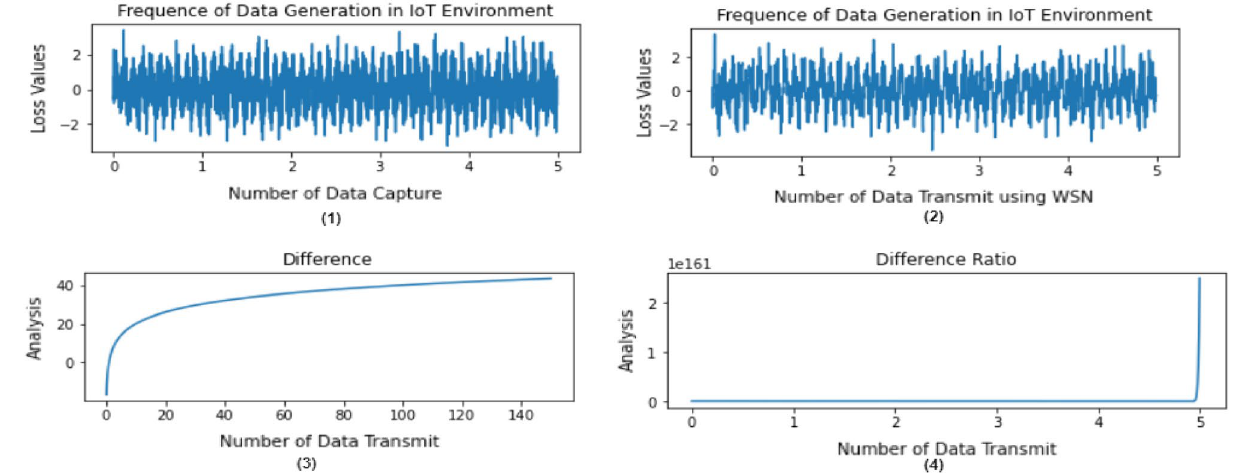
Figure 5. Frequency of data generation in IoT environment, ( 1 ) shows the number of data capturing, ( 2 ) shows the number of data transmitting, ( 3 ) shows the difference between the number of data transmission and analysis ( 1 ), and ( 4 ) shows the difference between the number of data transmission and analysis ( 2 ).